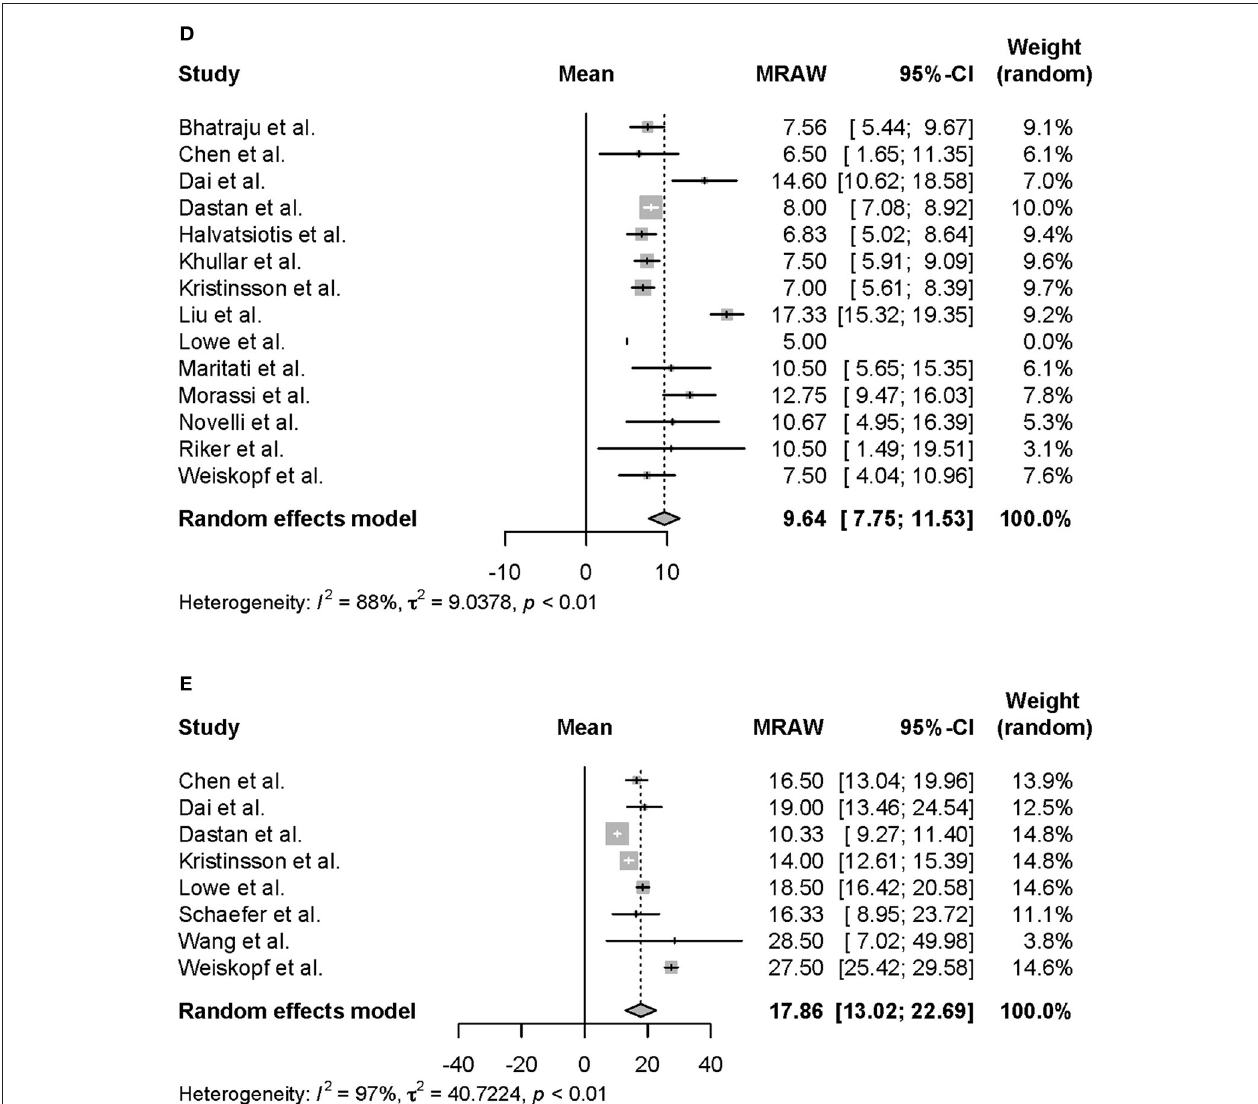
FIGURE 3 | Forrest plot: a meta-analysis of the time from symptom onset to each clinical endpoint in intubated COVID-19 patients. The prehospitalization period of intubated survivors (A) , the prehospitalization period of intubated non-survivors (B) , the preintubation period of intubated survivors (C) , the preintubation period of intubated non-survivors (D) , and the symptom-death period (E) were calculated using the random effects model. MRAW, the raw data of mean; 95% CI, 95% confidence